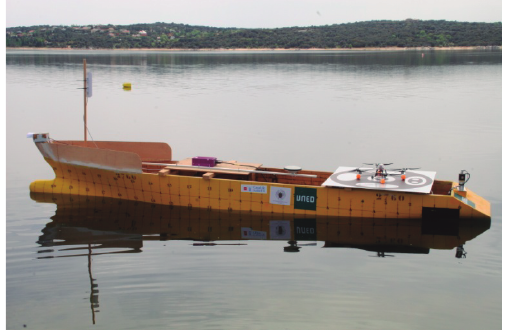
Figure 2: Scale ship model used in the experimental tests.